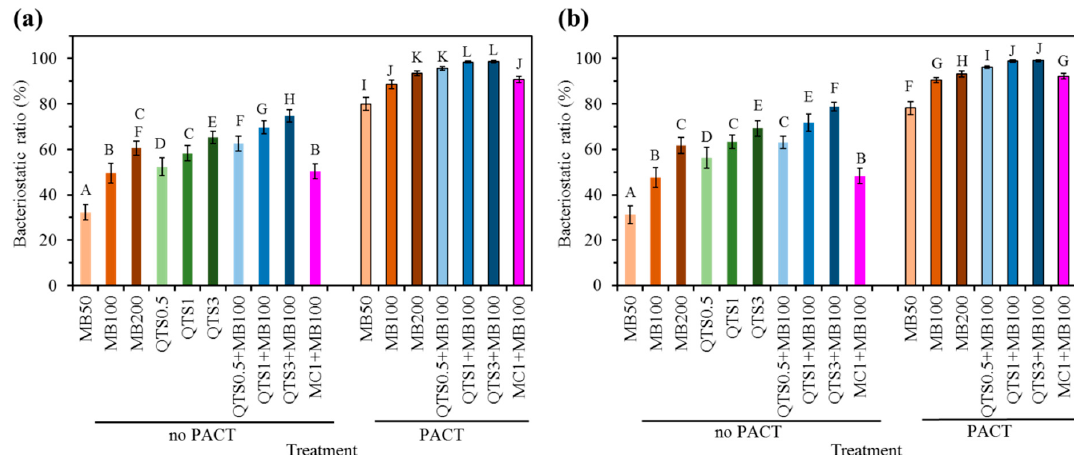
Figure 4. Bacteriostatic ratios of ( a ) A. actinomycetemcomitans -contaminated and ( b ) S. mutans -contaminated samples after various treatments with and without photoantimicrobial chemotherapy (PACT). Different capital letters showed statistically significant differences at p < 0.05 ( n = 10).